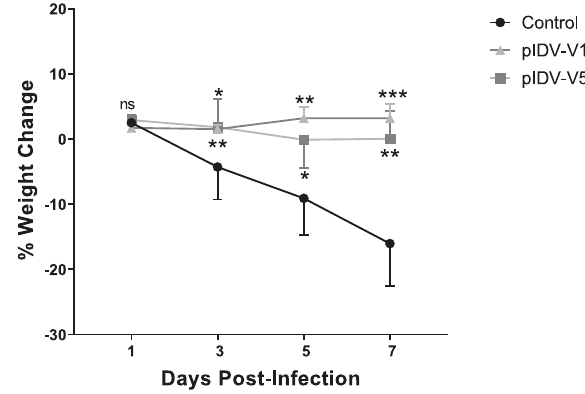
Fig. 3 Weight loss in animals following virus challenge. Animals were weighed throughout the course of infection and weight change was compared to pre-infection weight ( n = 8 per group). Error bars represent standard deviation. All * represent timepoints where P value <0.0001 as determined by two-way ANOVA.